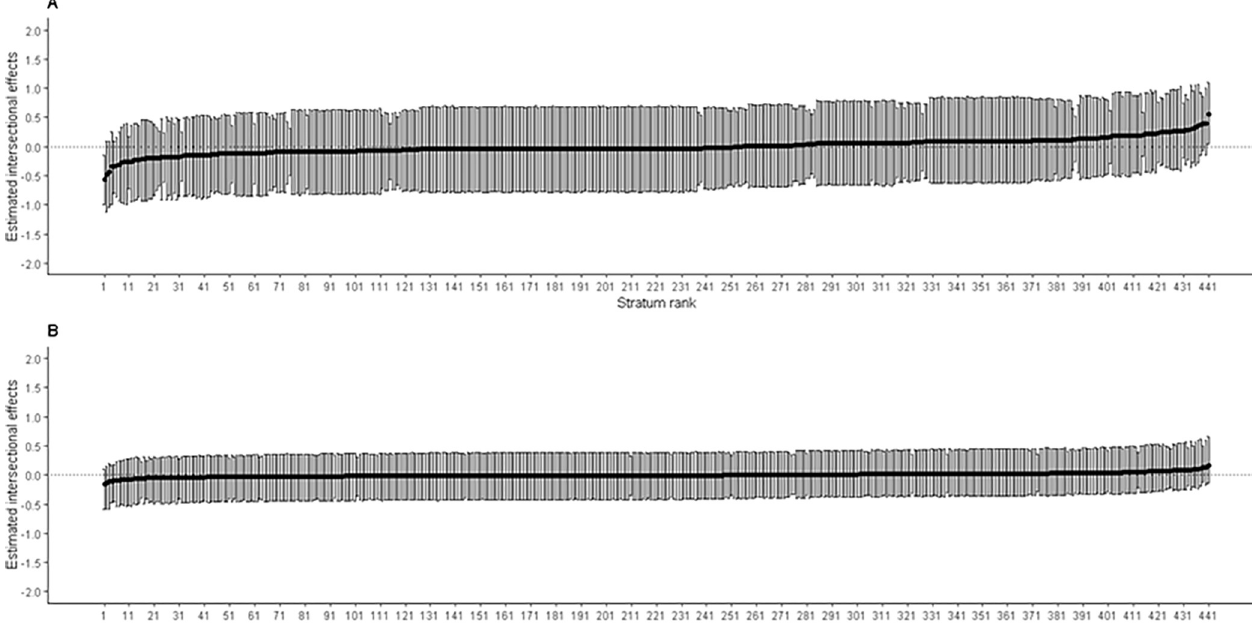
Fig 3. Estimated intersectional effects (stratum-level residuals) and their corresponding 95% credible intervals (CIs) for each stratum ranked from lowest to highest for fever. Panel A: An intercept model with only intersectional strata; Panel B: A full model after adding main effects (variables used to create intersectional strata) with intercept model. Negative values indicate lower risk (privileged groups) of fever in under-five ‘than expected’ based on the additive contributions of the main effects, while positive values indicate higher risk (disadvantaged groups) of fever in under-five ‘than expected’ for that stratum.